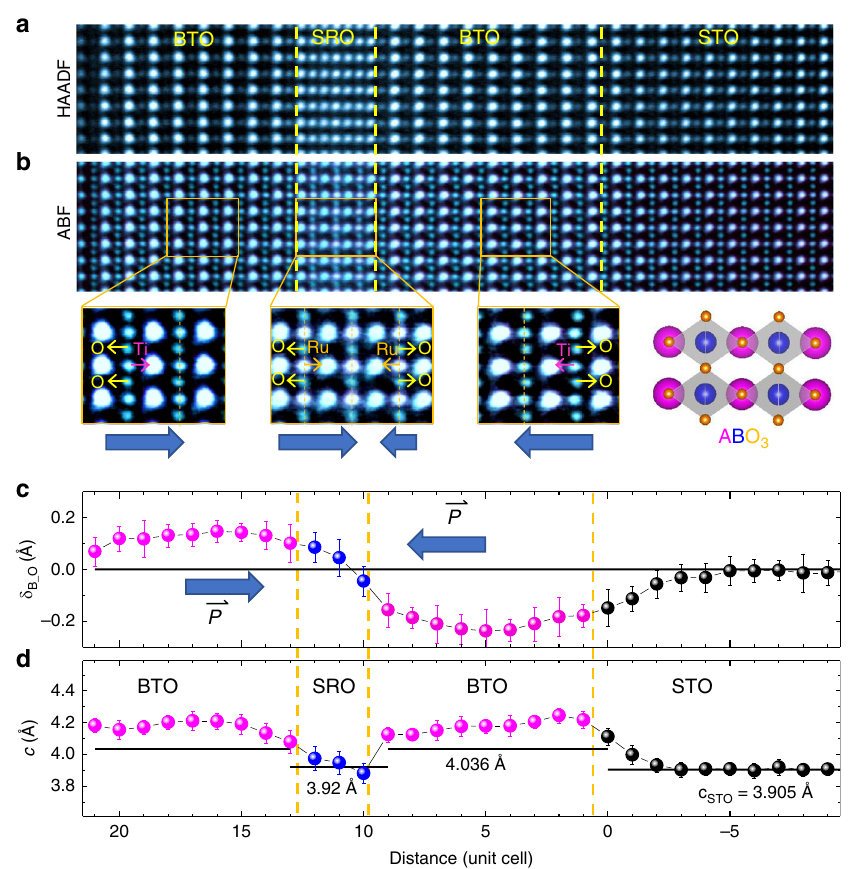
Fig. 1 Direct visualization of interfacial polar distortions in the BTO 9/3/10 fi lm. a HAADF- and b inversed ABF-STEM images taken along [110] direction. Enlarged ABF-STEM images showing polar distortions in the BTO and SRO blocks. Blue arrows indicate polar displacement direction. c Variation of polar displacements δ B-O across the whole fi lm. The polar displacements, δ B-O , refer to relative displacements between B site cations and O anions. d Out-of- plane lattice parameters, c , as a function of distance. The measurements were determined by averaging around 60 unit cells parallel to the interface. The error bar shows the standard deviations of the averaged measurements for each vertical atomic layer